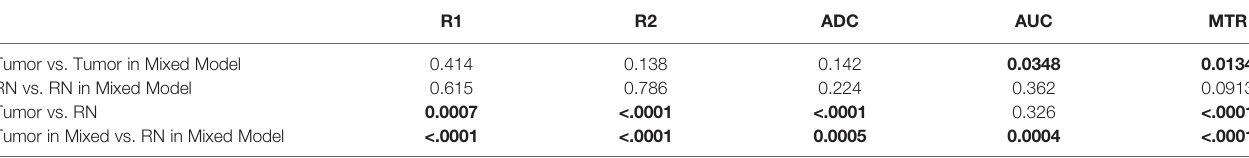
Bold values indicates statistical signi fi cance at p < 0.05 level.